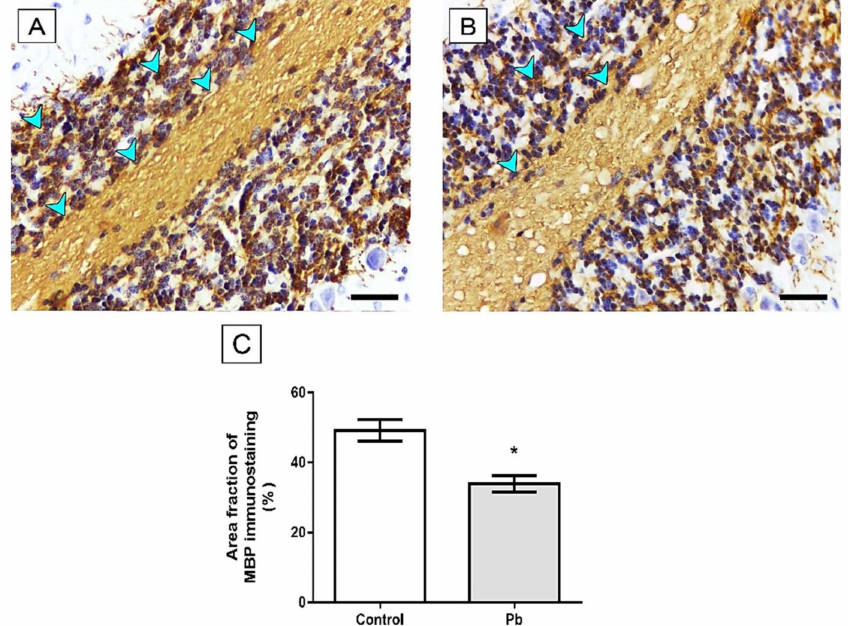
Figure 6. E ff ects of long-term exposure to Pb in Myelin basic protein (MBP) immunostaining (blue arrowhead) in cerebellum of Wistar rats. ( A ) Control group and ( B ) Lead group. The results are expressed as mean ± standard error of ( C ) area fraction percentage of immunostaining. * p < 0.05 compared to control group (Mann–Whitney test). Scale bars: 20 µ